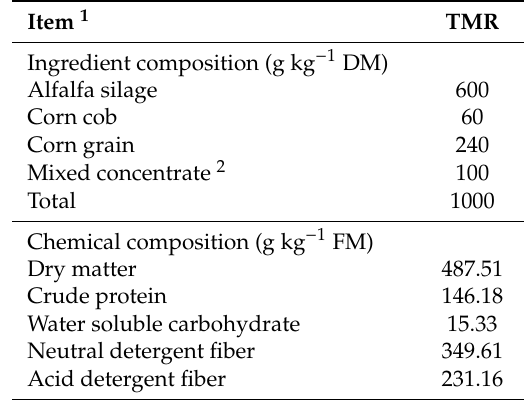
Table 2. Ingredient composition and chemical composition of the total mixed